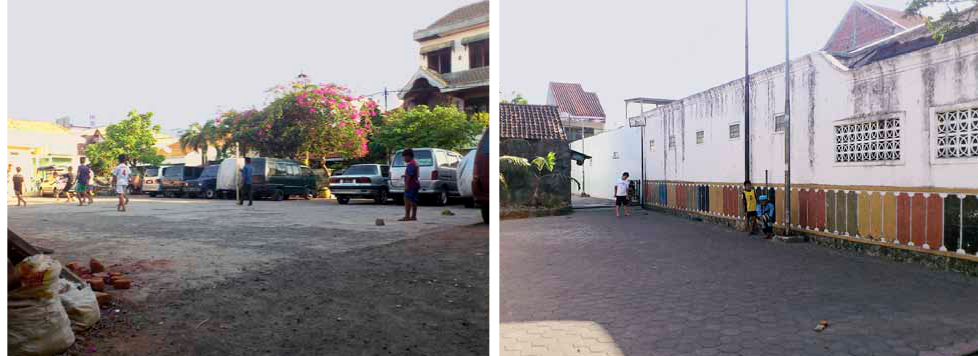
fig. 7. left – a field in front of the neighbourhood association hall used as a playground for children and also as a parking lot. right – a small empty space in front of a medical post in rT 4 (photo by the